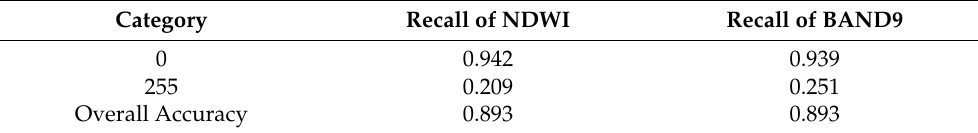
Table 10. Quantitative comparison results of water extraction from the Washington DC Mall data set.